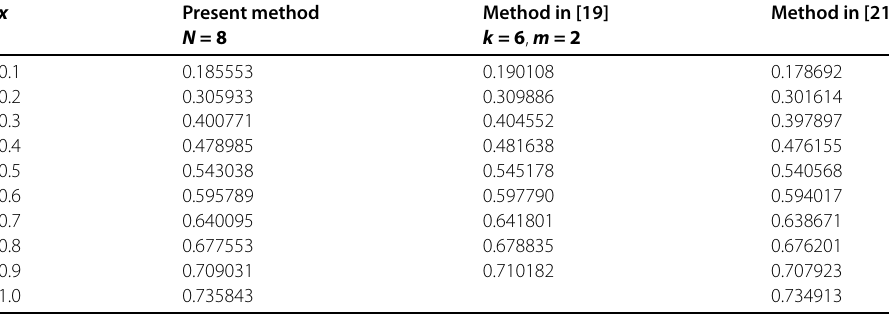
Table 3 Comparison of the numerical solutions with the other methods for α = 3/4 of Example